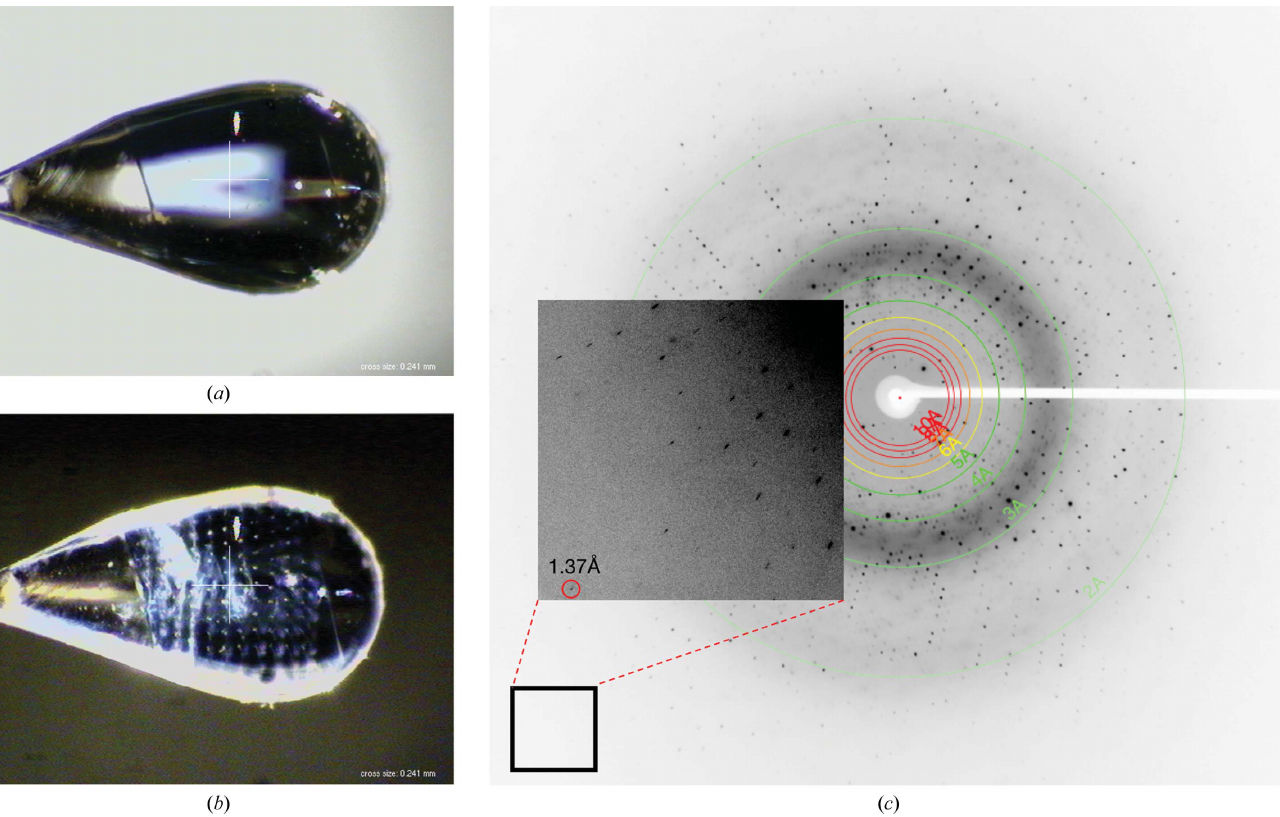
Figure 1 Ax NiR SF-ROX data collection. The crystal is shown ( a ) before and ( b ) after XFEL beam exposure. The crystal size is approximately 1 (cid:4) 0.7 (cid:4) 0.08 mm. Holes drilled by the X-ray laser are clearly visible corresponding to the top left to bottom right data-collection strategy. Each hole is 50 m m apart, with a 0.1 (cid:6) rotation between each snapshot. The XFEL diffraction setup was the same as that described by Hirata et al. (2014). The blue colour of the crystal shows the oxidation state of the copper site. ( c ) A diffraction image from an Ax NiR crystal obtained on BL3 at SACLA. The maximum visible resolution spots appear at 1.37 A˚